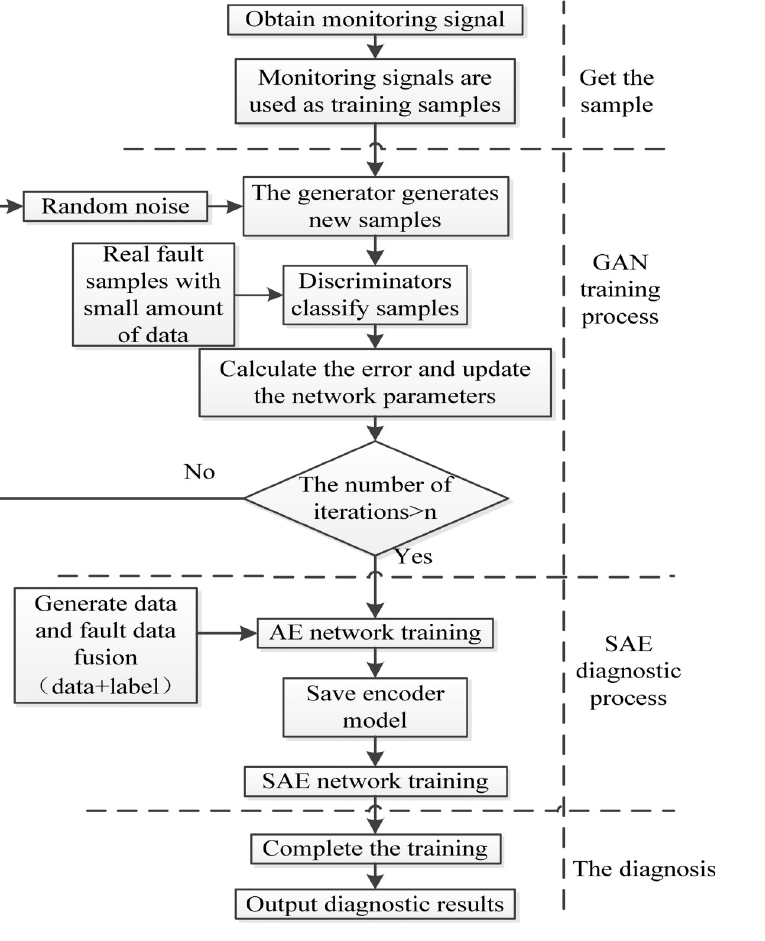
Fig 4. Flow chart of GAN-SAE